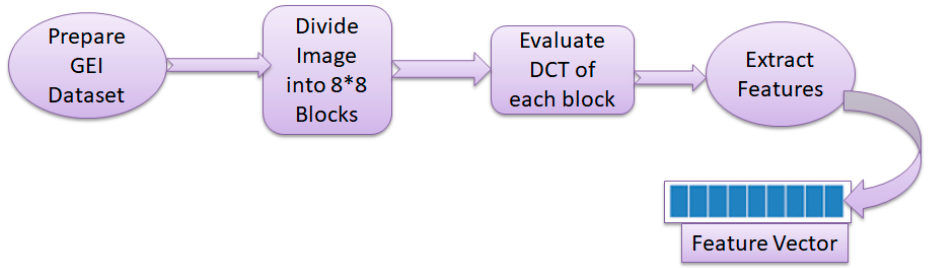
Figure 3. Flowchart for DCT feature extraction. Figure 4 is a pictorial representation of the coefficients of DCT along with the GEI.